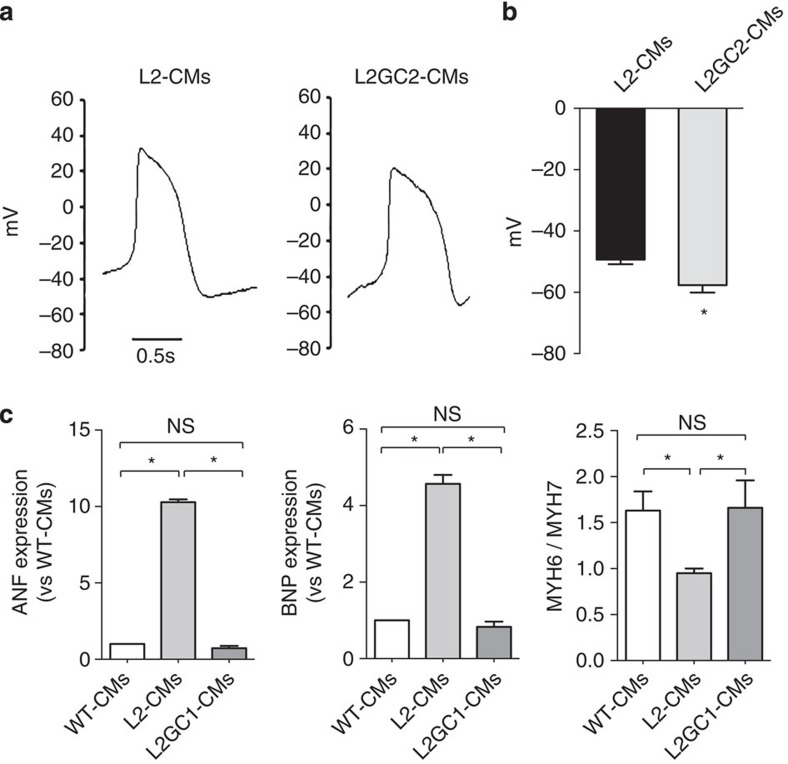
Gene correction improves elephysiological and hypertrophic phenotypes.(a) Representative action potentia (AP) waveforms of spontaneously beating cardiomyocytes. The AP properties of single cells were analysed using the patch-clamp method; (b) Analysis of maximum diastolic potential. Values represent mean±s.e.m. (n=14 L2-CM and n=22 L2GC2-CM). *P<0.05 L2-CMs versus L2GC2-CMs (unpaired student's t-test); (c) Quantitative PCR analysis of gene expression of cardiac hypertrophy markers ANF, BNP, MYH6 and MYH7 in isogenic CMs. ANF and BNP gene expression was normalized to GAPDH housekeeping gene and expressed as relative expression to the WT-CMs. MYH6 and MYH7 expression was normalized to GAPDH housekeeping gene and presented as MYH6/MYH7 ratio. Values represent mean±s.e.m. (n=6 per group). *P<0.05 (unpaired student's t-test). NS, not significant.